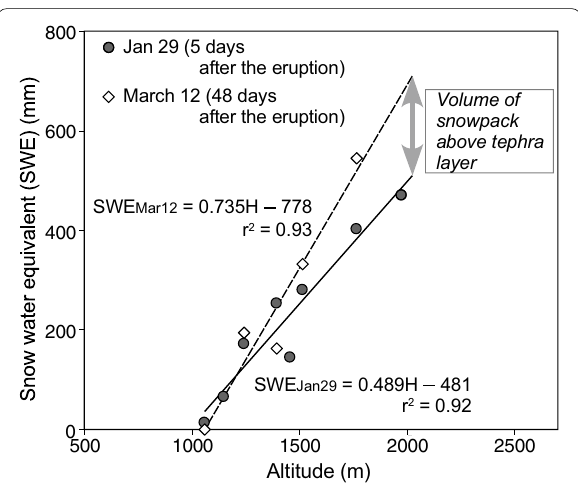
Fig. 8 Snow water equivalent on 29 January and 12 March 2018 showing accumulation above tephra